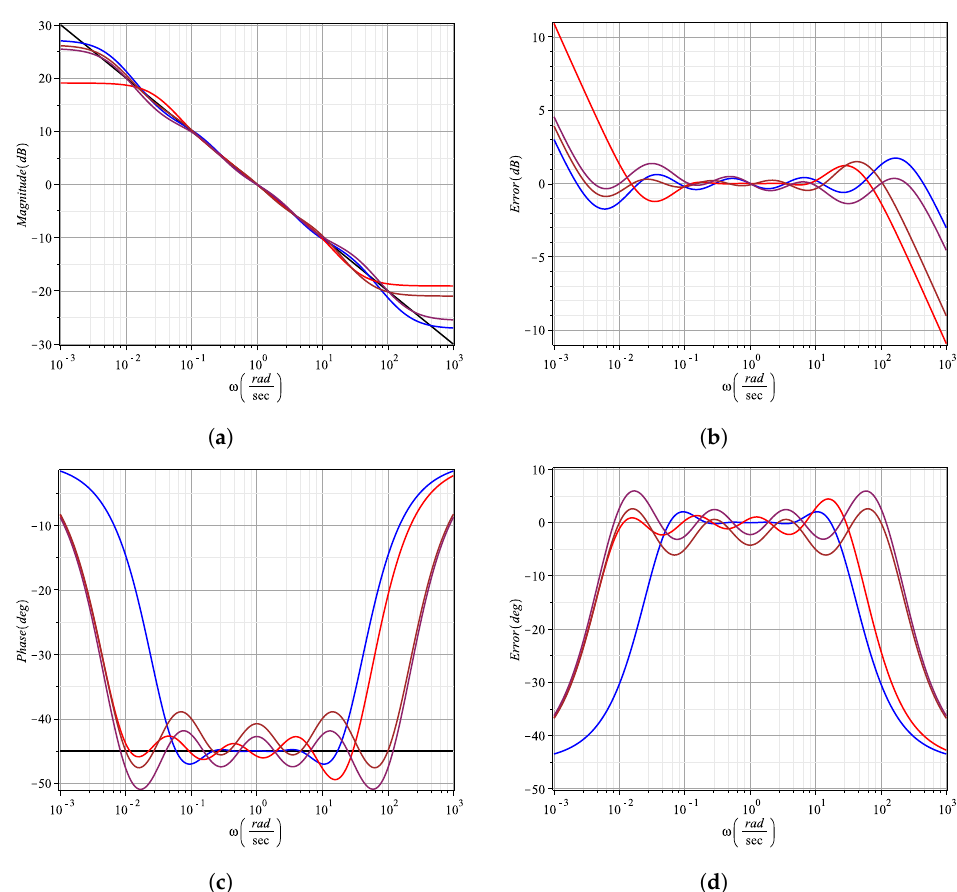
Figure 3. Ideal behavior (black line), Matsuda’s (blue line), continued fraction expansion (red line), curve fitting (brown line) and MSBL (maroon line) approximation for 1 ( b ) Magnitude error. ( c ) Phase response. ( d ) Phase error.